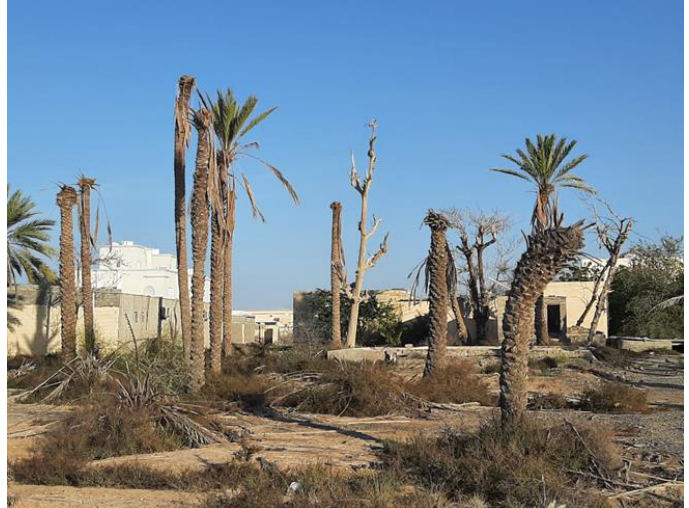
Figure 2. An abandoned date palm garden in Al Batinah, Oman, due to salinity intrusion (Photograph taken by Javed Akhtar on 17 December 2021) .